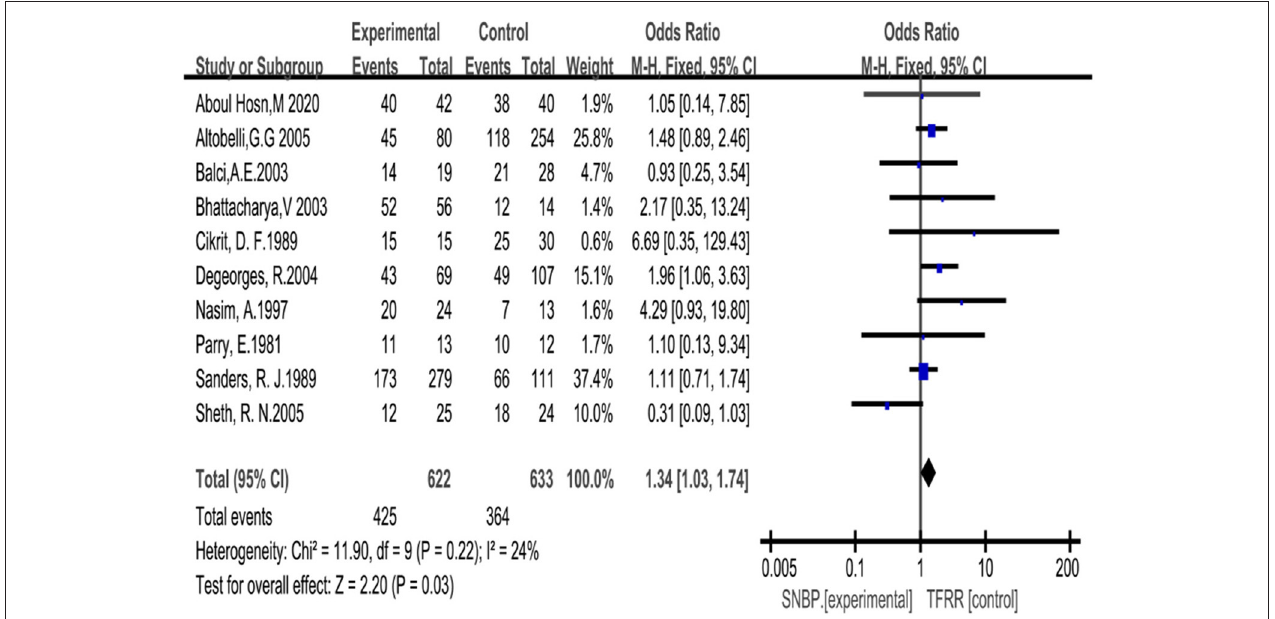
FIGURE 2 | Forrest plot for improvement of upper limb function with SNBP and TFRR. CI, confidence interval.